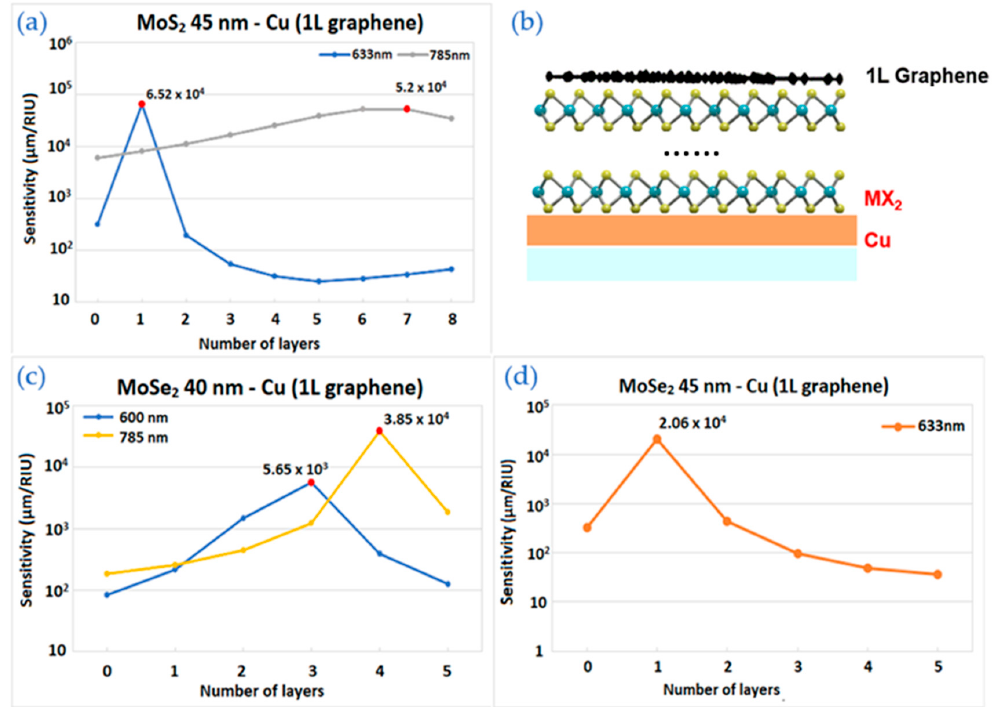
Figure 5. The sensitivity values of the enhanced model with 1 layer of graphene by TMDC layers and thickness of copper: ( a ) The wavelengths are 633 nm and 785 nm for MoS 2 layers with 45 nm of copper; ( b ) the schematic structure; ( c ) The wavelengths are 600 nm and 785 nm for MoSe 2 layers with 40 nm of copper; ( d ) The wavelength is 633 nm for MoSe 2 layers with 45 nm of copper.